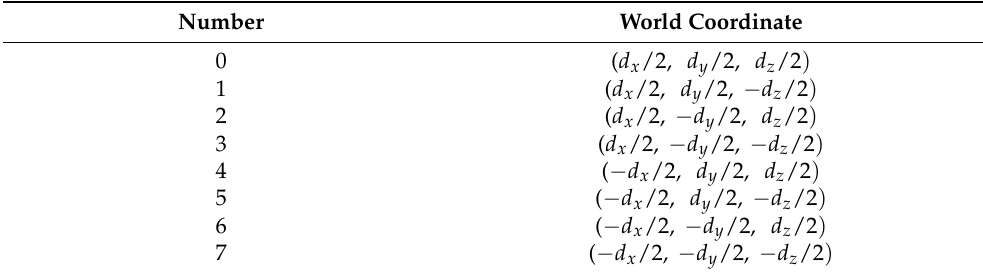
Table 2. World coordinates of eight vertices when positioned at the vehicle’s